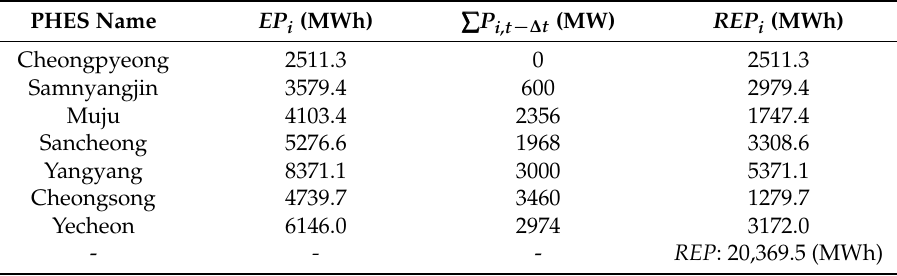
Figure 2. PHES P i,t − ∆ t for the peak-load day in 2016. Table 5. EP i and P i,t − Δ t on the peak-load day in 2016.